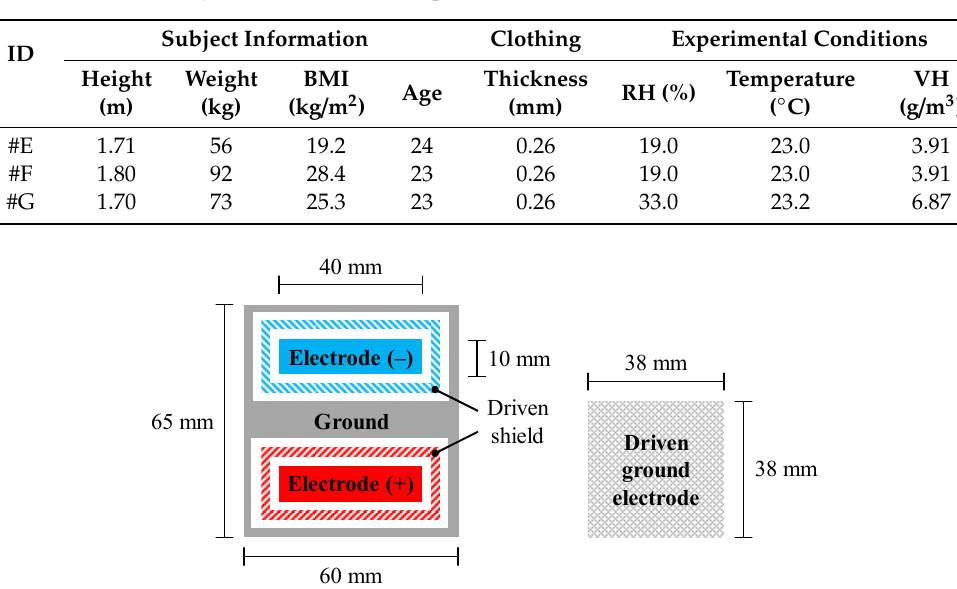
Table 3. Subject information and experimental conditions in cEMG measurement.